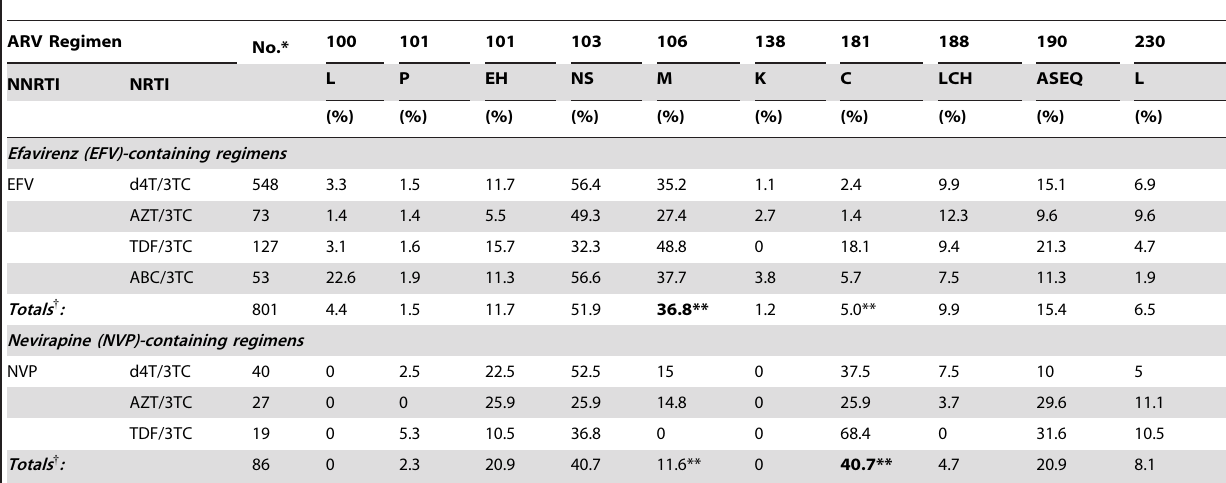
Footnote: *No.: Number of patients receiving first-line therapy with the ARV regimen indicated in the first two columns. { The proportion of individuals treated with NVP or EFV. Mutations for which there were statistically significant differences according to the NNRTI received: **p # 0.001. Fewer sequences were included in table 4 than in table 3 as sequences that terminated between positions 219 and 229 were excluded from the numerator and denominator for NNRTI mutation